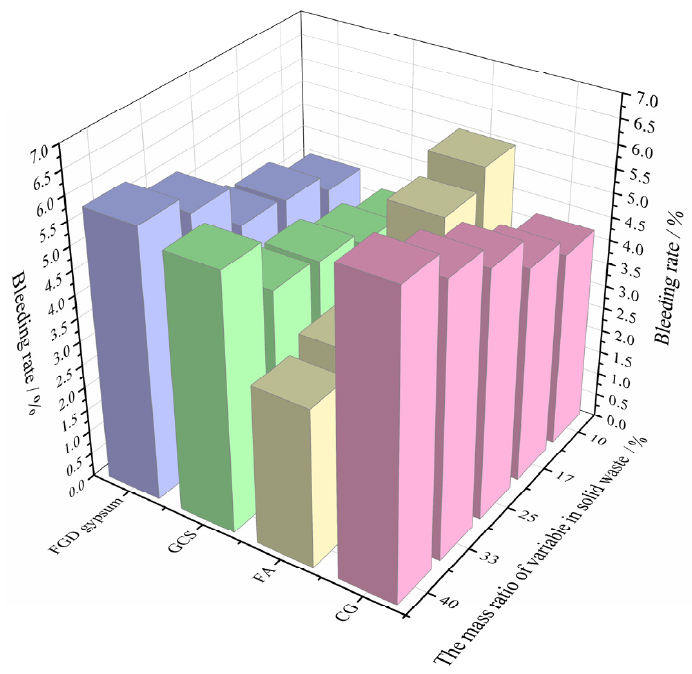
Figure 6. Bleeding-rate test results.